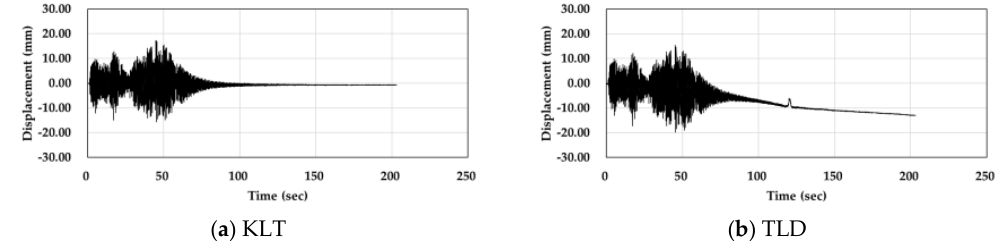
Figure 8. Time-displacement curve using different object tracking algorithms.